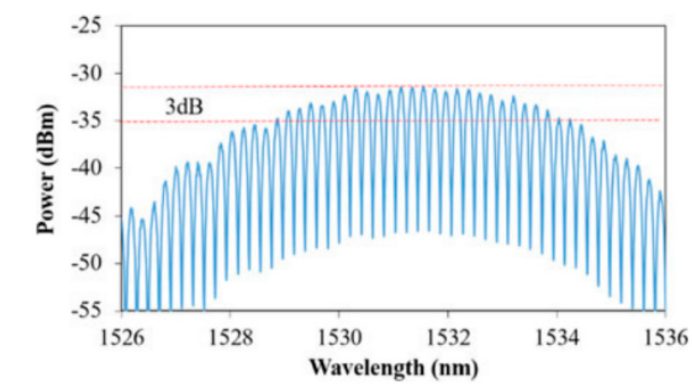
Figure 14. Generation of 24 channels within 3-dB flatness [109].